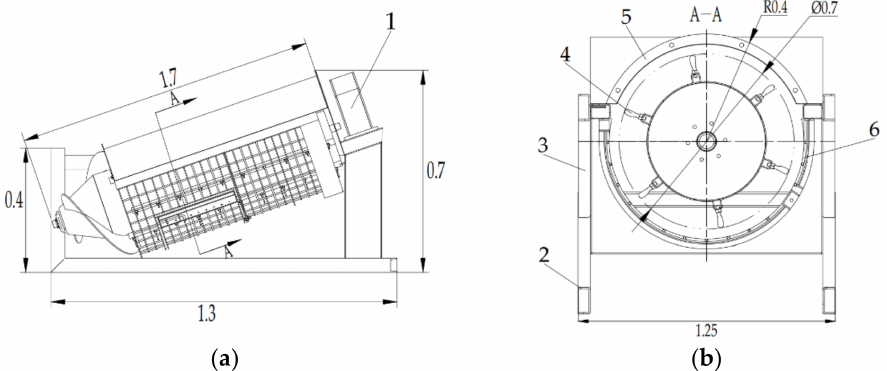
Figure 2. Structural diagram of an axial-flow pod-pickup drum: 1. Gearbox; 2. Lower frame; 3. Side frame; 4. Pod-pickup teeth; 5. Deflector; 6. Concave grate. ( a ) Front view and ( b ) cutaway view.